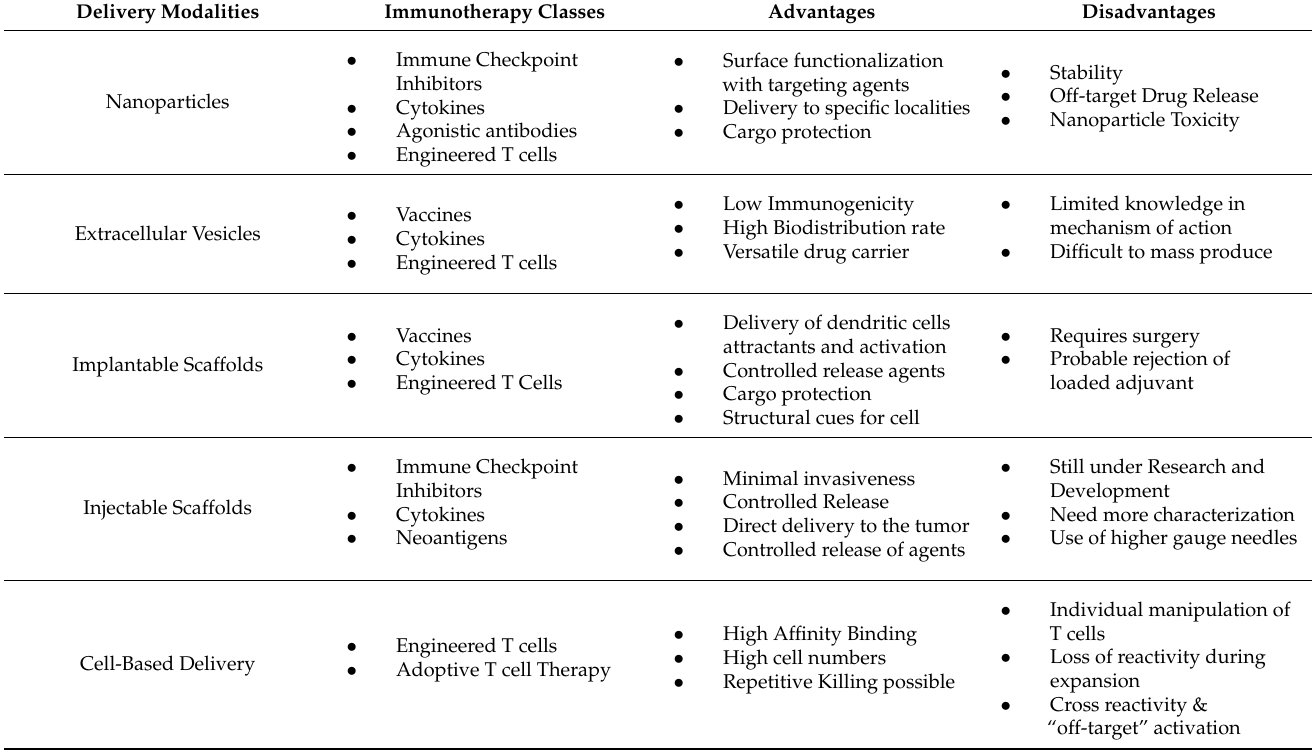
Table 4. Advantages and disadvantages of delivery techniques in cancer